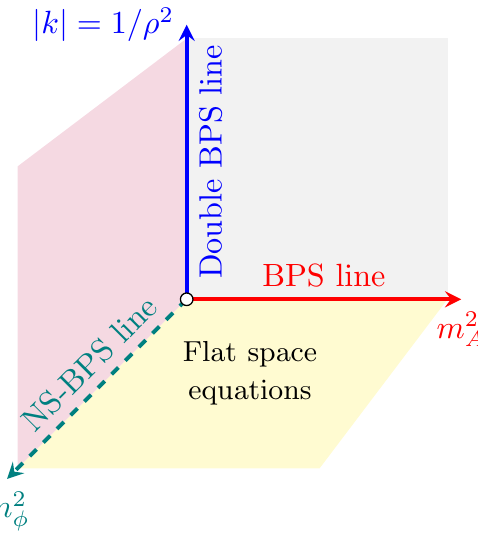
Figure 1 . The equations of motion for our Higgs model depend on three mass scales m 2 k = 1 =(cid:26) 2 if l 2. We explore the parameter space for analytic maximally symmetric solutions j j (cid:21) to the equations of motion in section 5. The Prasad-Sommer(cid:12)eld limiting solutions lie along the BPS line. There are no solutions that satisfy our boundary conditions along the green dashed line labeled NS-BPS. We (cid:12)nd new exact spherically symmetric analytic solutions along the double BPS line. In section 6 we show that for parameter values in the pink plane m 2 solution for the gauge (cid:12)eld, but the scalar (cid:12)eld has to be studied numerically. The gray plane m 2 0 is where Lugo, Moreno and Schaposnik looked for BPS monopole solutions in AdS 4 , see (cid:30) # appendix B and (cid:12)gure